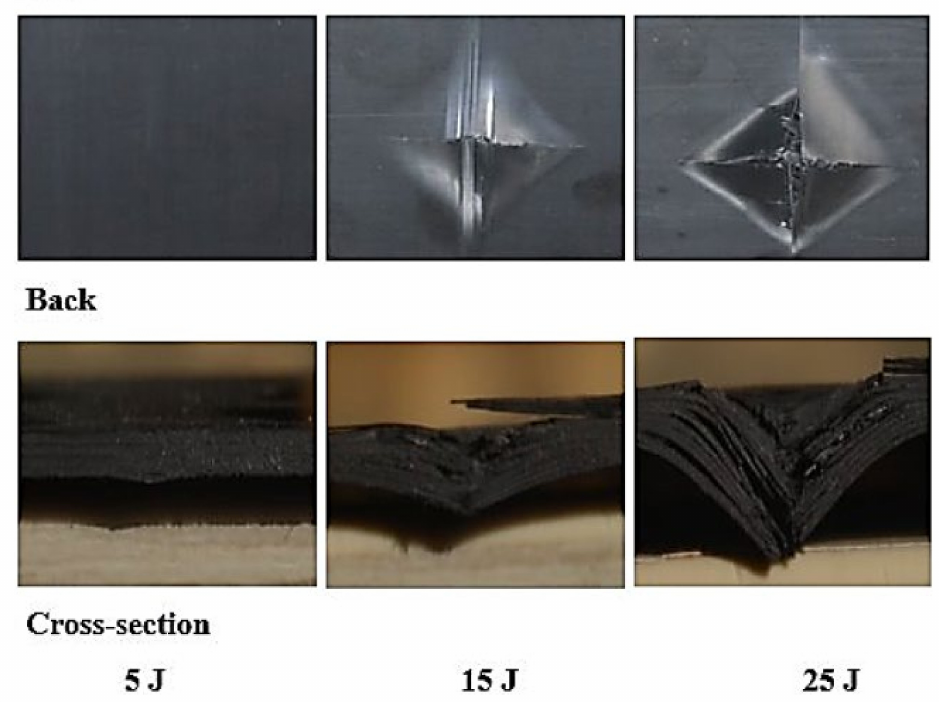
Figure 13. Pictures of the top and bottom surfaces and cross-sectional view of [A/B] at 5, 15, and 25